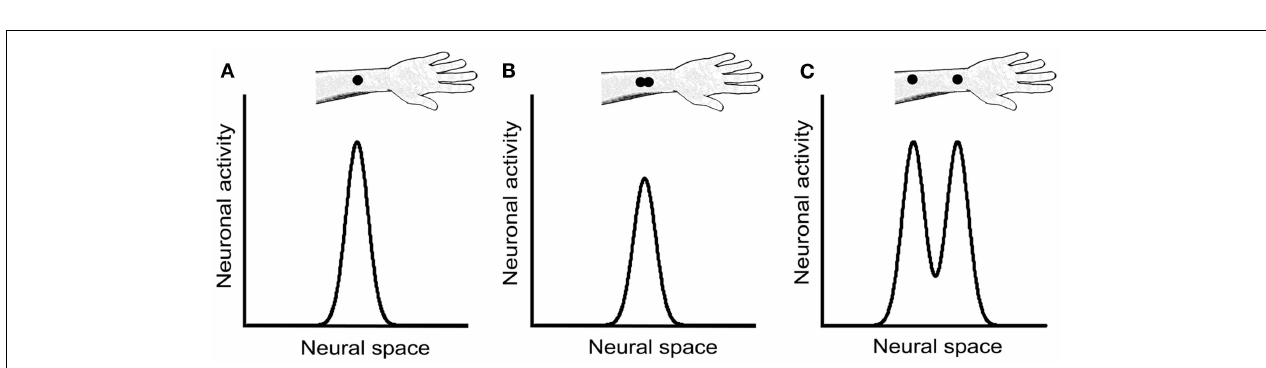
FIGURE 7 | 95%-correct thresholds versus receptor spacing . Participants’ 95%-correct thresholds for 2PD (A) and 2POD (B) plotted against estimated SA-1 receptive field spacing (Johansson andVallbo, 1979; Olausson et al.,